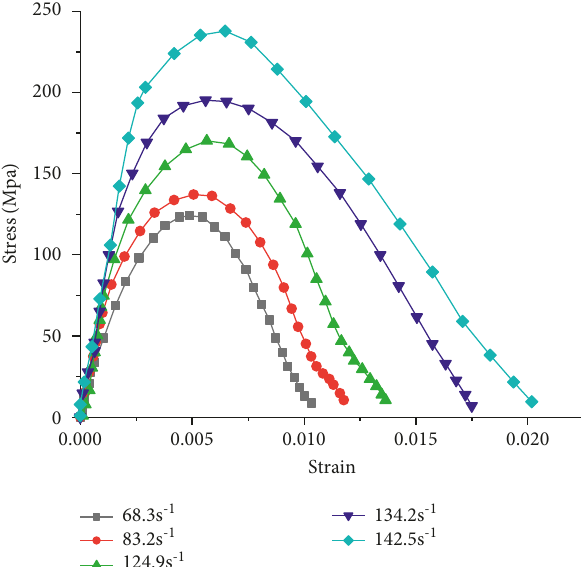
Figure 7: Dynamic compressive stress-strain curves of rock at different strain rates.